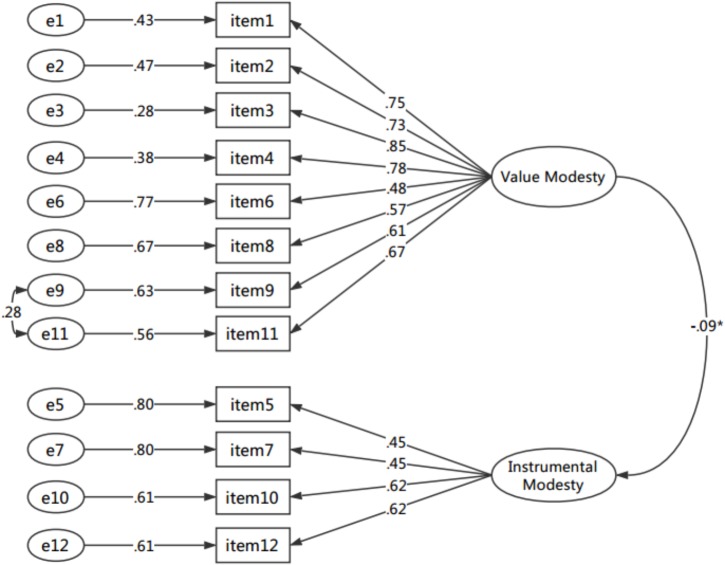
CFA results on CMS scale.